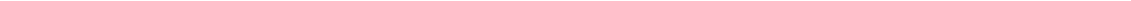
test. l CFSE fl uorescence intensities quantifying CD4 + effector T cells (Teff) proliferation. Teff were incubated alone (black curve), with CD3 + CD25